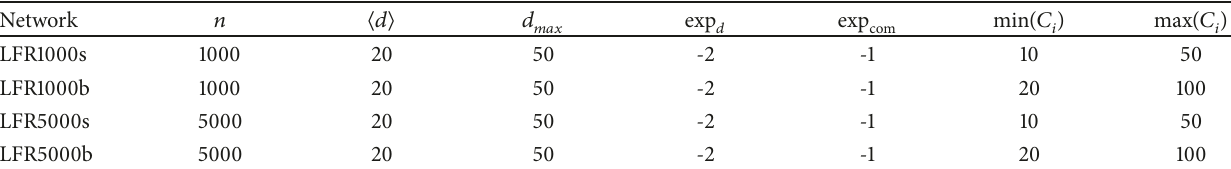
Table 1: The parameters used to generate the LFR networks. In the header row of this table, 𝑛 is number of nodes contained in the network; ⟨𝑑⟩ and 𝑑 𝑚𝑎𝑥 are the average degree and the max degree, respectively; exp 𝑑 and exp 𝑐𝑜𝑚 are the exponents of the power law distributions that node degree and community size follow; min (𝐶 𝑖 ) and max (𝐶 𝑖 ) represent the minimal and maximal number of nodes contained in every community, respectively.